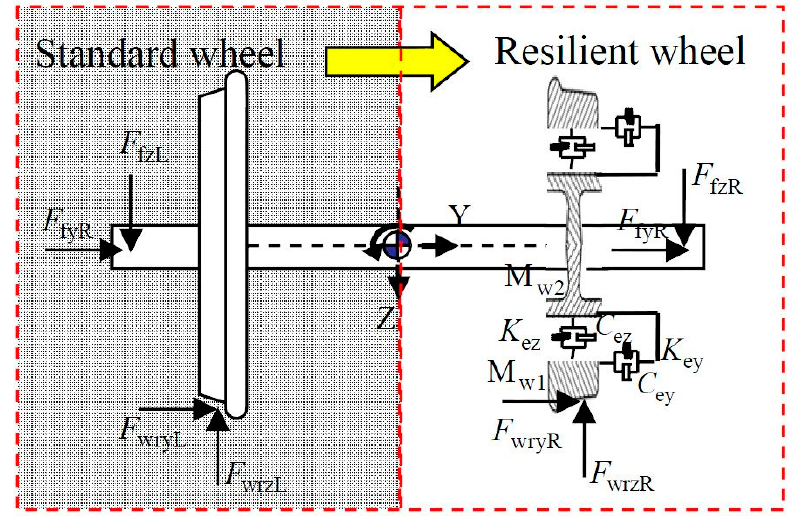
Figure 5. Dynamic model of resilient wheel.